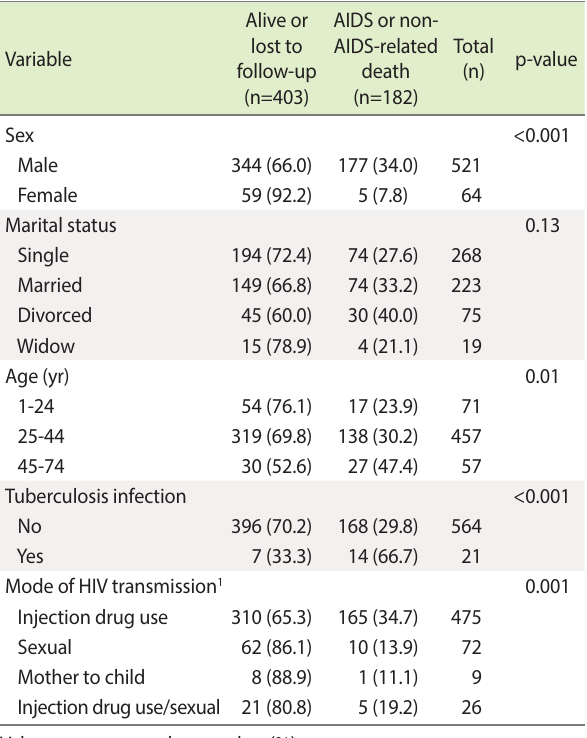
Table 1. Predictor factors of the patients by their final outcome in a cohort study in Hamadan, Iran (1997-2011) Variable